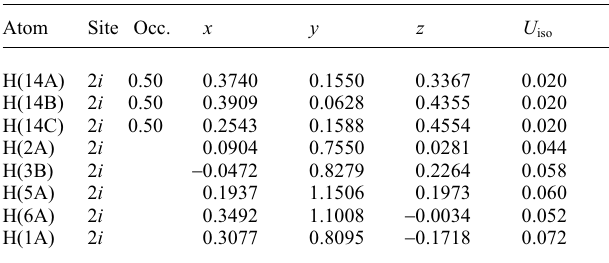
Table 2. Atomic coordinates and displacement parameters (in Å 2 )